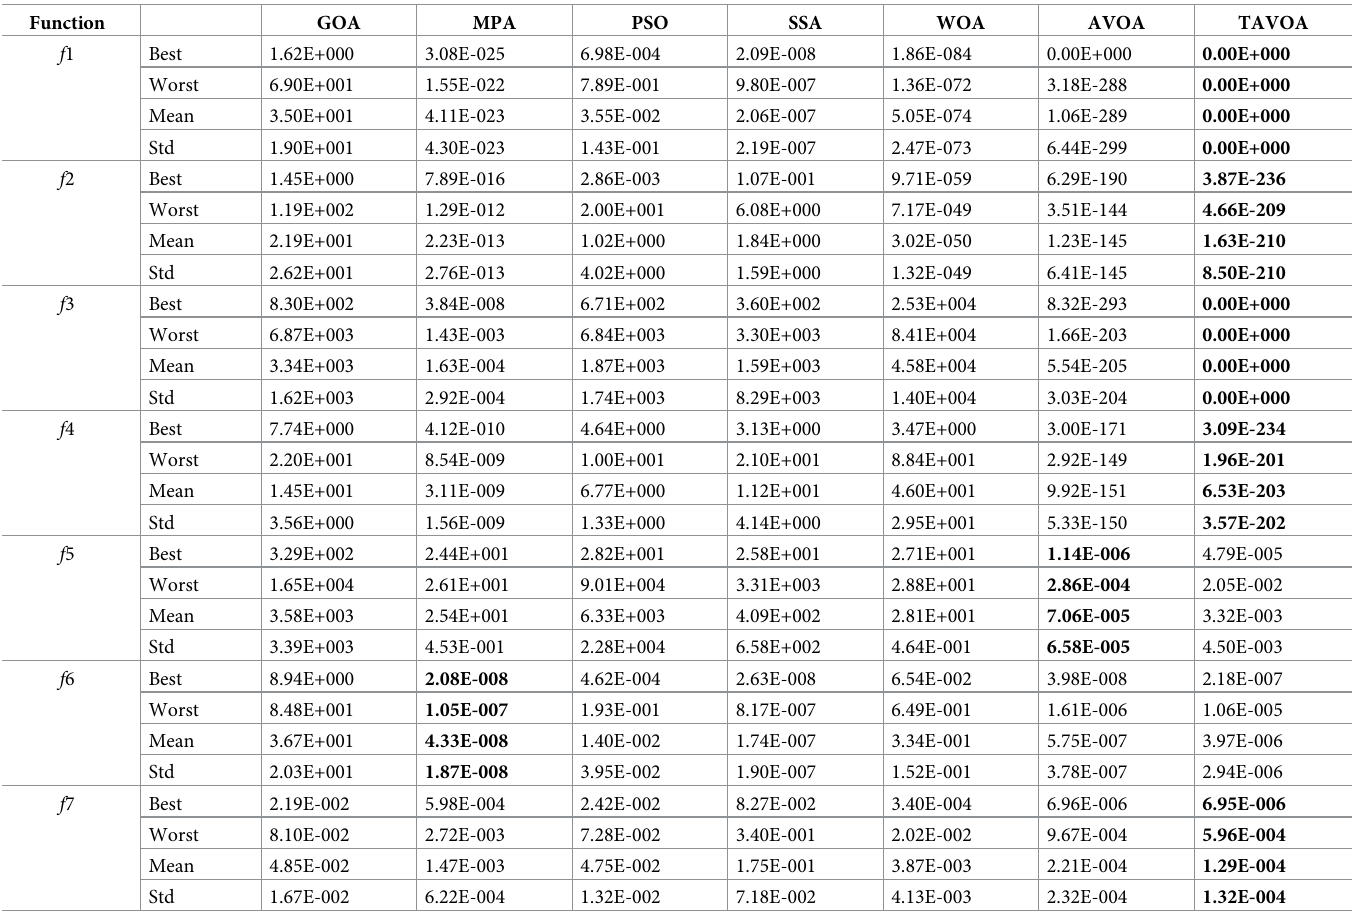
Table 3. Experimental results of basic unimodal benchmark functions ( f 1 − f